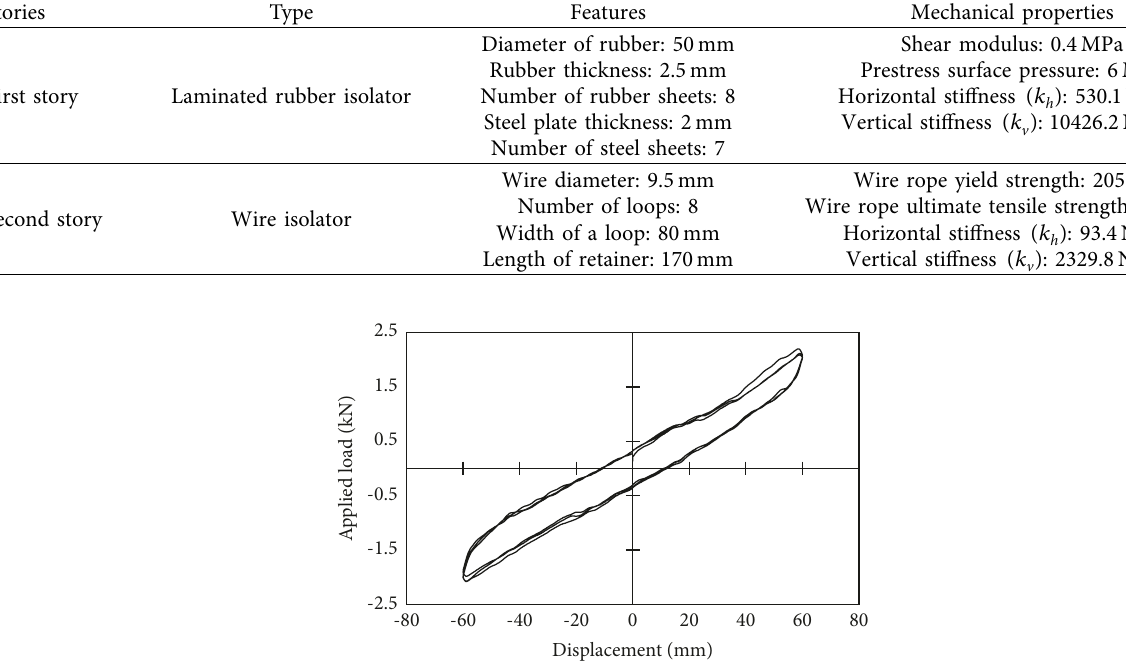
Figure 4: Load-displacement of a single isolator system under cyclic